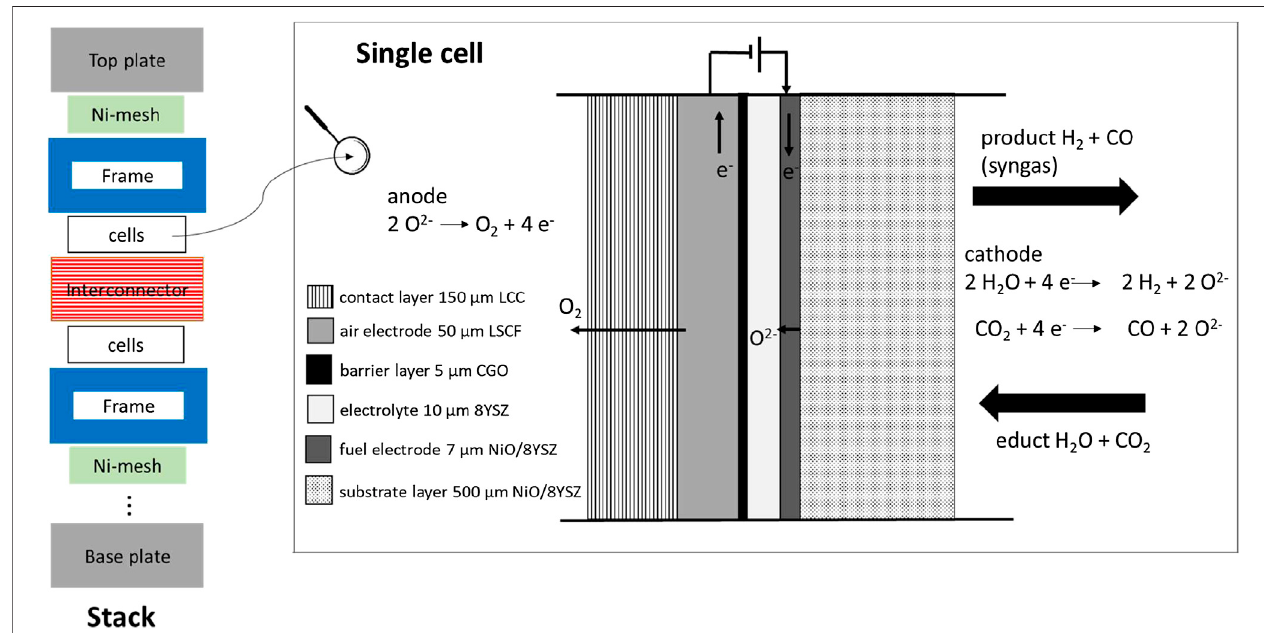
FIGURE3| Schematic illustration oftheJülich F Y 10stackdesignbasedonFang et al.(2015) and anincluded single cell(Menzleretal.,2014;Harboe et al.,2020).